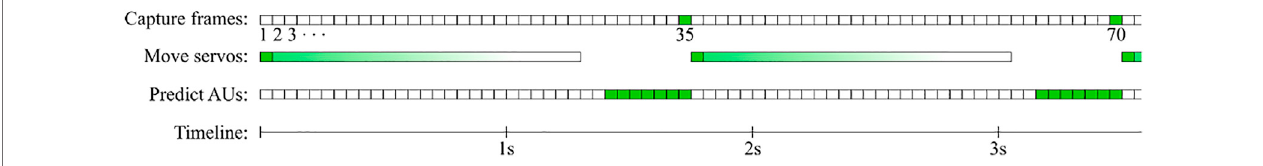
FIGURE 4 | Illustration of the data capturing and analysis procedure. Each square represents one iteration, where green denotes the stages where data are recorded.